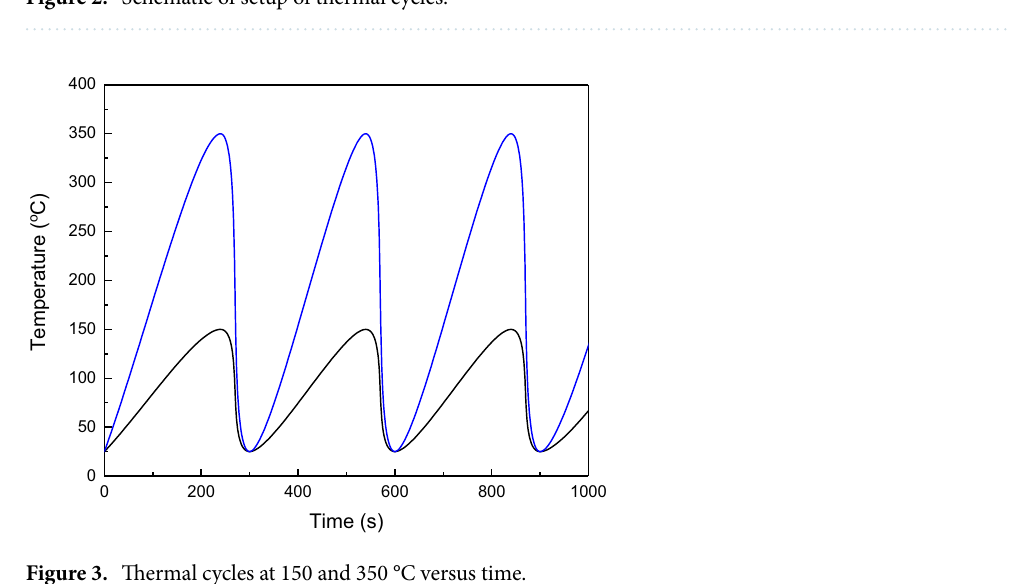
Figure 2. Schematic of setup of thermal cycles.